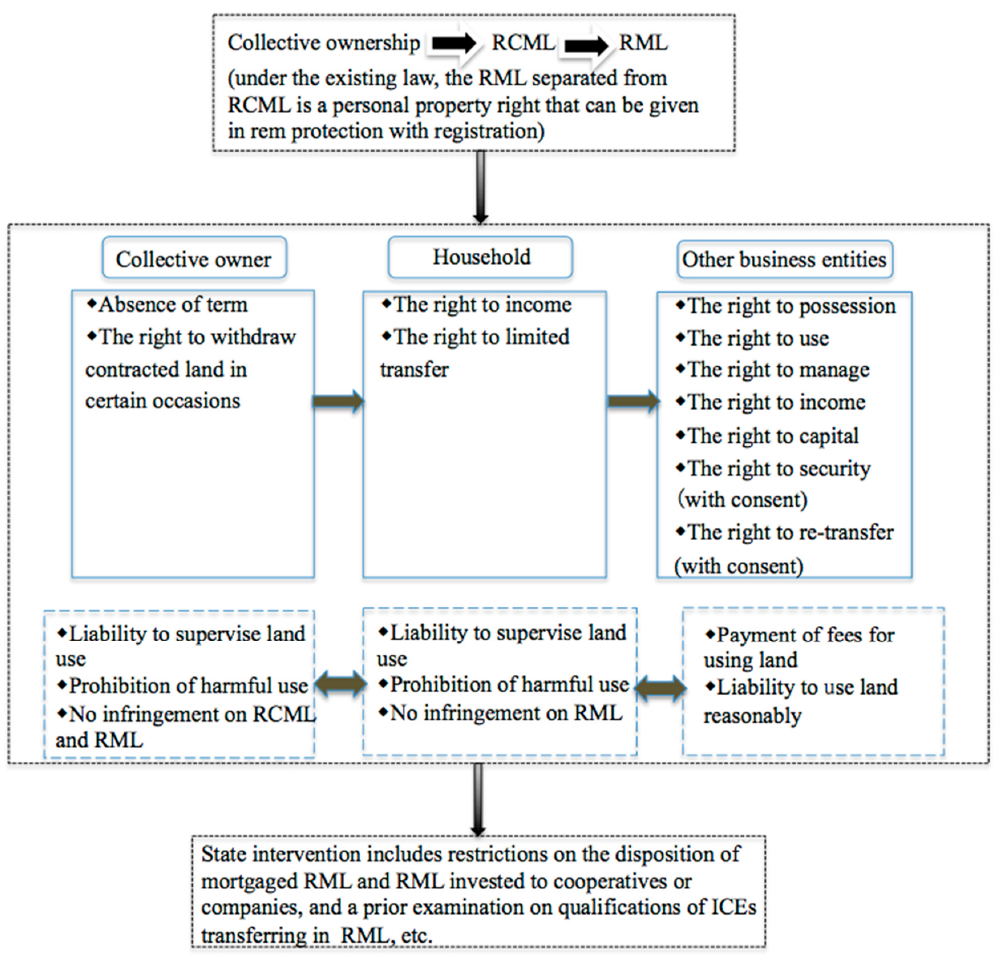
Figure 4. A three-step analysis of the trifurcation of rights on contracted farmland. Figure 5. A three-step analysis of the trifurcation of rights on contracted